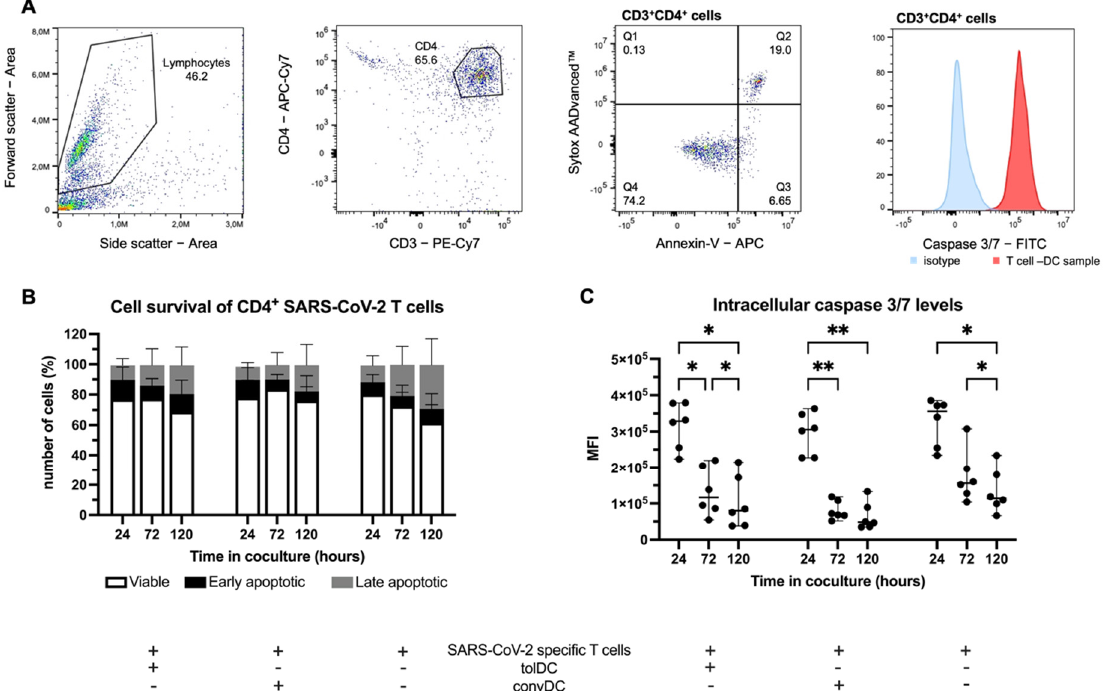
Figure 3. The induction of T cell hyporesponsiveness by tolDC is T cell apoptosis-independent (n = 6). ( A ) Gating Strategy for the flow cytometric follow-up of T cell apoptosis. Lymphocytes are selected based on light scatter properties (FSC/SSC), and, subsequently, CD3 + CD4 + T cells are gated. Next, a quadrant gating is used to differentiate between viable cells (SytoxAADvanced − Annexin-V − ), early apoptotic cells (SytoxAADvanced − Annexin-V + ) and late apoptotic cells (SytoxAADvanced + Annexin-V + ). The expression levels of caspase 3/7 are assessed via MFI histograms. ( B ) Follow-up of viable (white), early apoptotic (black) and late apoptotic (grey) cells in T cell–DC cocultures as compared to T cells alone by means of flow cytometry. ( C ) Mean fluorescence intensity of intracellular caspase 3/7 levels in T cell–DC cocultures at different timepoints, indicated as the median and interquartile range. Significance is indicated by * ( p < 0.05) and ** ( p < 0.01).